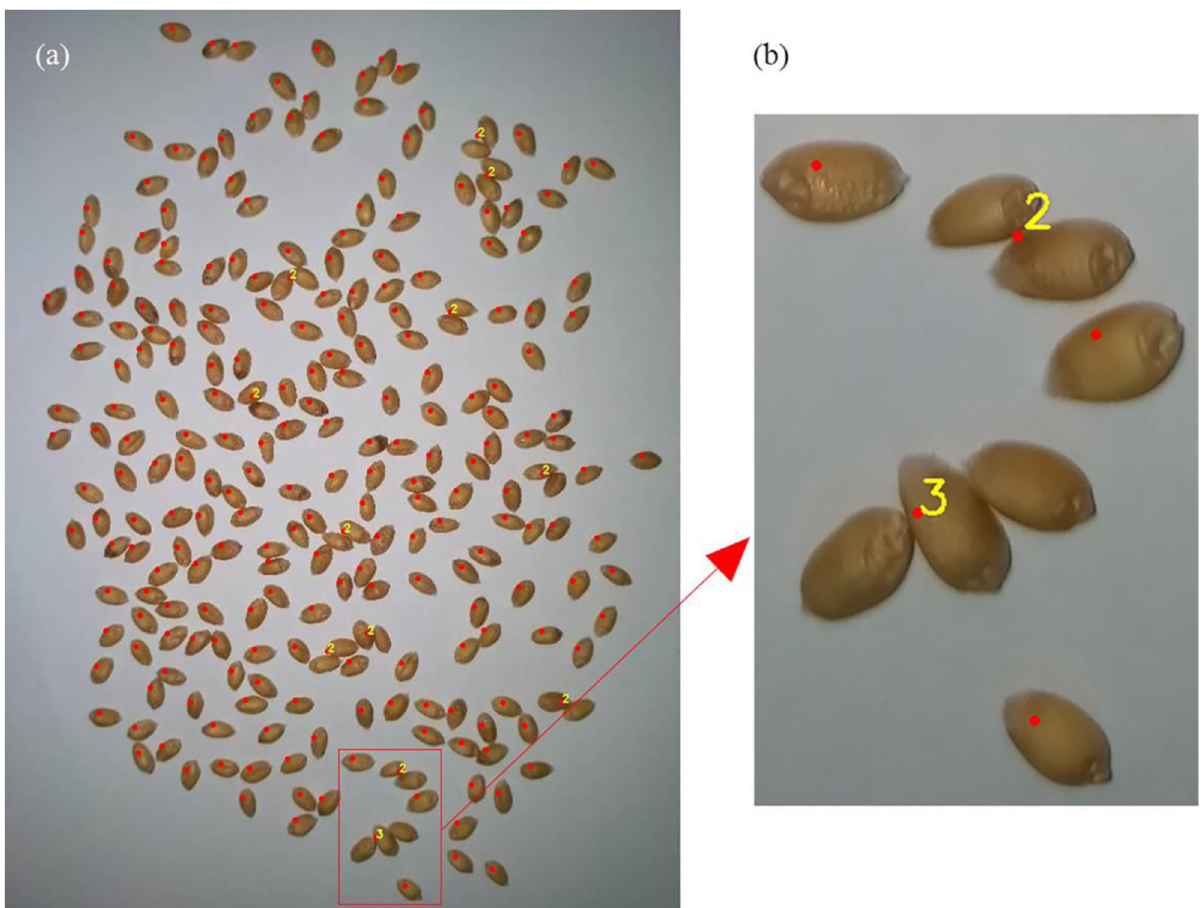
Fig 8. Grain counting result. Note. A: Counting result graph. B: Meaning of the red dots and numbers.